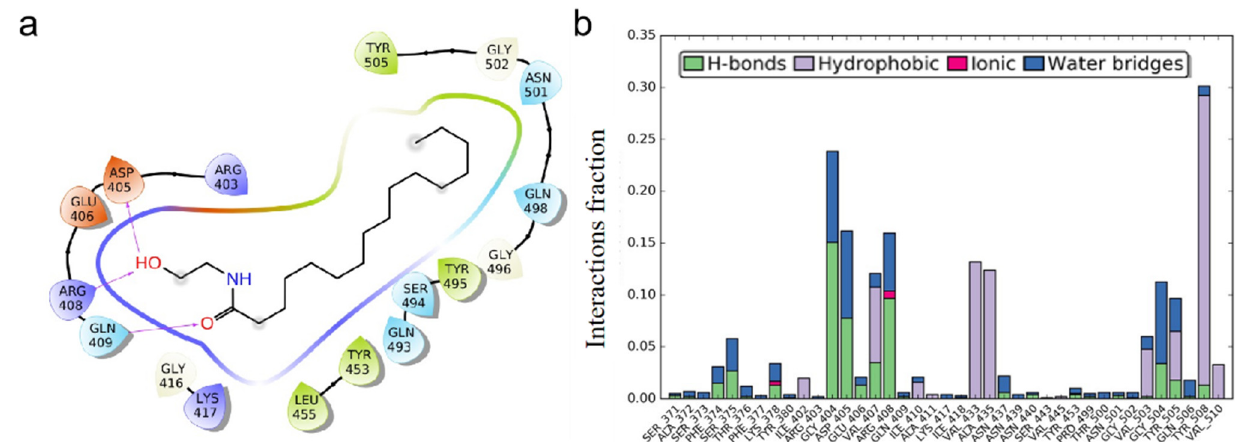
Figure 1. PEA interacts with SARS-CoV-2 S protein. ( a ) Binding mode of 6LZG with PEA after docking: “->” represents hydrogen bond interaction. ( b ) Amino acid residual interaction fractions in interaction with PEA.